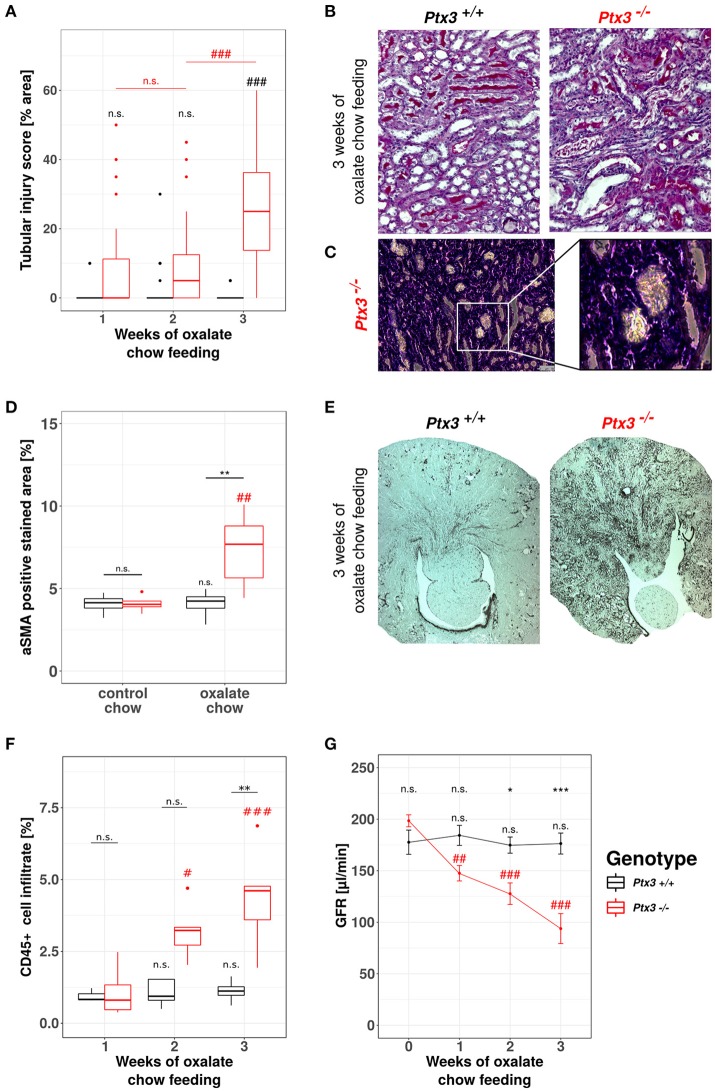
Lack of PTX3 induces hyperoxaluria-induced progressive CKD in non-susceptible B6;129 mice. Ptx3+/+ and Ptx3−/− female littermates (10–12 weeks of age) were fed with oxalate chow for 3 weeks (n = 9). (A) Quantification of tubular injury was conducted using PAS-stained kidney sections as shown in (B). (C) Phase contrast image of crystal plugs in H&E-stained kidney section in 200× (left) and 400× (right) magnification. (D) Quantification of αSMA-positive area in kidney sections after 3 weeks of either control or oxalate chow feeding as shown in (E). (F) Percentage of CD45+ cells within whole kidney cell suspension assessed by flow cytometry. (G) GFR assessed by transcutaneous measurement of FITC-sinistrin from subcutaneous capillaries at weeks 0, 1, 2, and 3 after onset of high oxalate diet in both genotypes. Data are from four independent experiments and represent means ± SEM in (G). n.s., not significant; *p < 0.05, **p < 0.01, ***p < 0.001 vs. wild type and respective #, ##, and ### vs. week 1 as indicated.